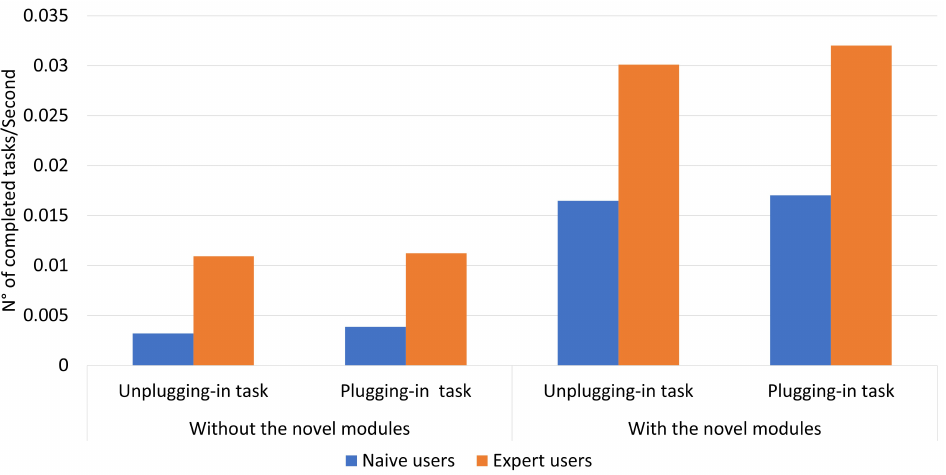
Figure 9. Time-based efficiency of the two tasks performed without and with the two novel